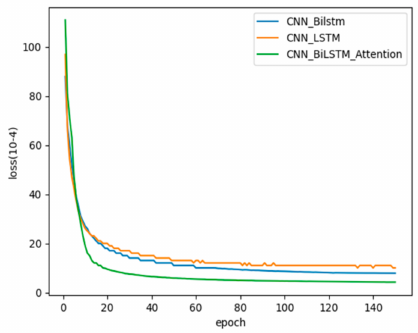
Figure 10. Comparisons of convergence speed in three deep learning